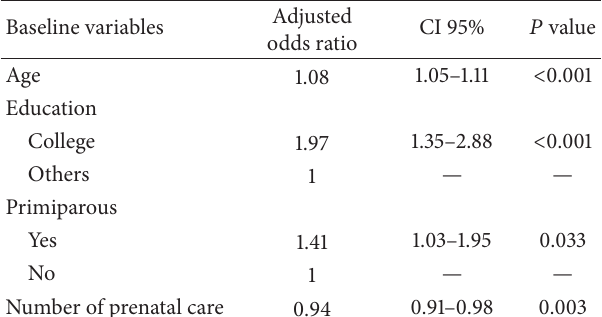
Table 4: Baseline characteristics associated with near miss